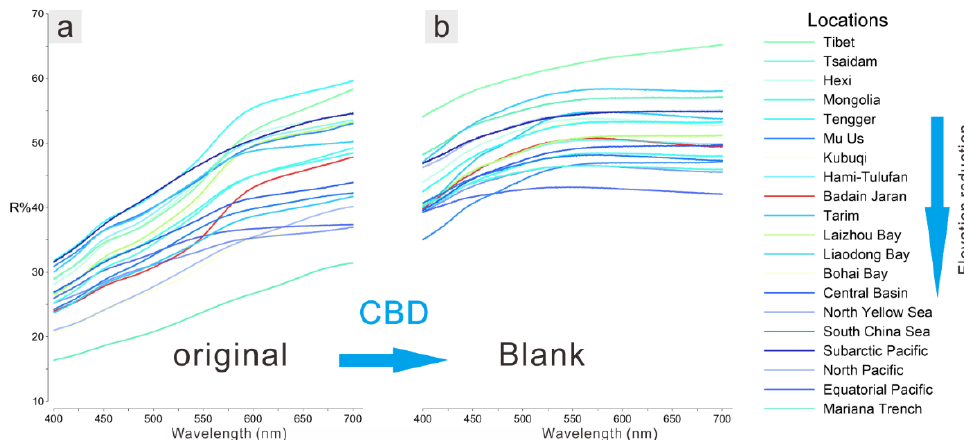
Figure 5. Reflectance spectra of natural samples before ( a ) and after ( b ) CBD processing.